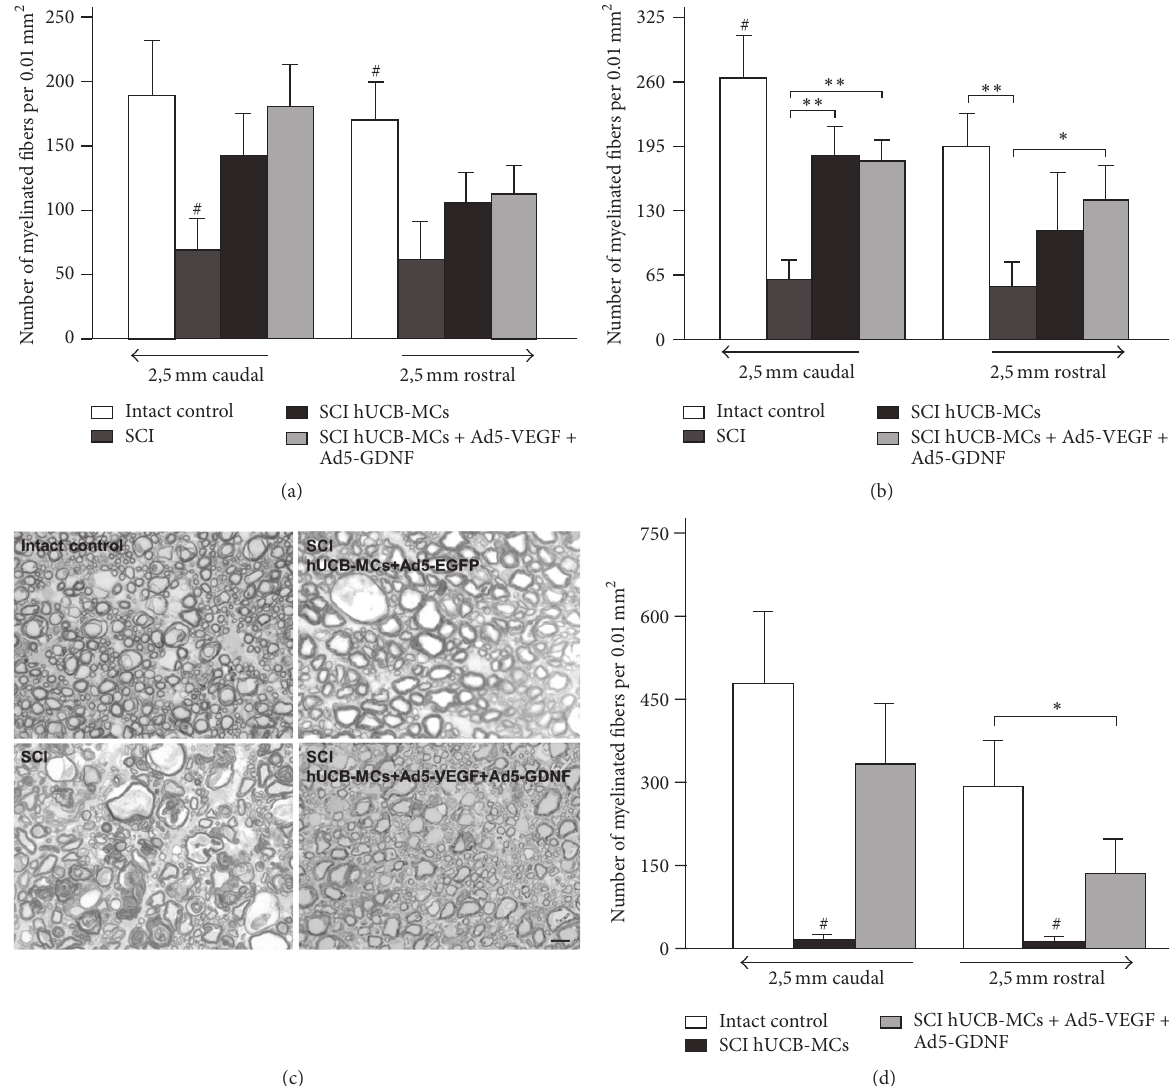
Figure 2: Analysis of myelinated fibers. The average number of spared myelinated fibers in the lateral (a) and ventral funiculi (b) of spinal segments 2.5 mm rostral and caudal to the lesion epicenter at day 30 after injury. Differences were statistically significant between SCI/intact and other experimental groups ( # 𝑃 < 0.05 ). ∗ 𝑃 < 0.05, ∗∗ 𝑃 < 0.01 one-way ANOVA followed by a Tukey’s post hoc test. ( c ) Fragments of the ventral funiculi at a distance of 2.5 mm from the SCI/Th8 epicenter in the caudal direction at day 30 after injury. The images are methylene blue-stained semithin sections. Scale bar: 10 𝜇 m. (d) The average number of spared myelinated fibers in the CST of spinal segments 2.5 mm caudal and rostral to the lesion epicenter/Th8 at day 30 after injury. Differences were statistically significant between SCI hUCB-MCs and other experimental groups ( # 𝑃 < 0.01 ). ∗ 𝑃 < 0.05 one-way ANOVA followed by a Tukey’s post hoc